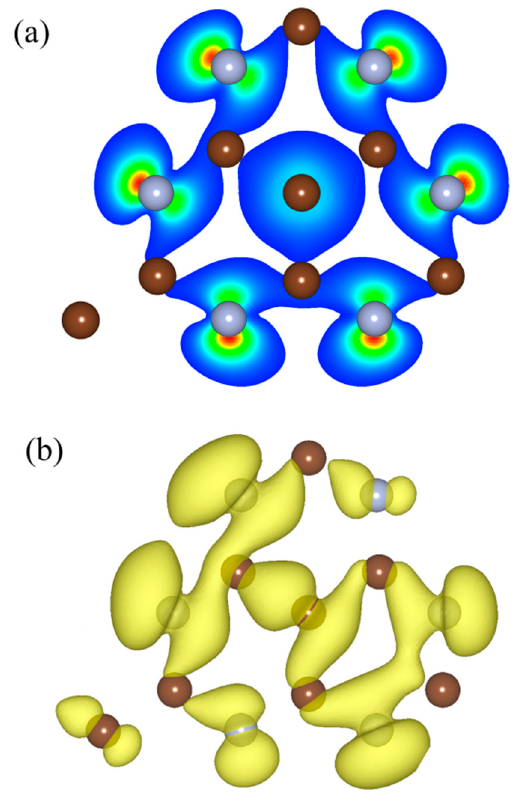
Figure 4. ( a ) Charge density of the conduction band minimum (CBM), which is located on K point of the 32nd energy band; ( b ) charge density of the valence band maximum (VBM), which is located on M point of the 31st energy band. The isosurface value is set to 0.003 Å − 3 .